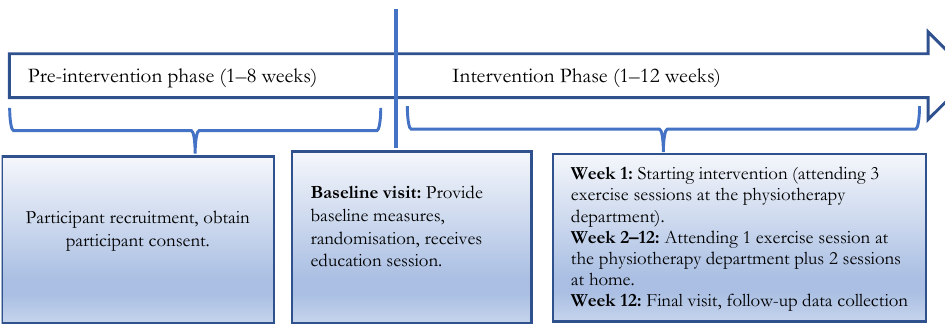
Figure 1. Intervention timeline.